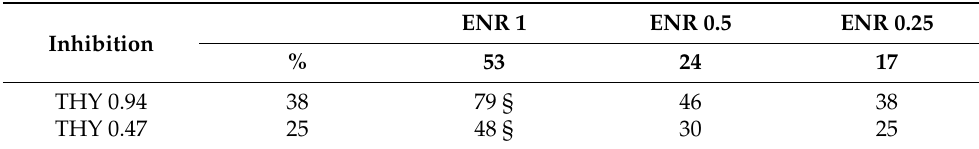
Table 6. Percentage inhibition of the five ETEC strains resistant to amoxicillin in the presence of combinations of amoxicillin (AMO, mg/L) and thymol (THY, mM). AMO 64 AMO 32 AMO 16 Inhibition % 9 14 16 THY 0.94 25 15 26 27 THY 0.47 21 15 24 25 Table 7. Percentage inhibition of the three ETEC strains resistant to neomycin in the presence of combinations of neomycin (NEO, mg/L) and thymol (THY, mM). NEO 64 NEO 32 NEO 16 Inhibition % 6 8 8 THY 0.94 16 11 10 10 THY 0.47 10 9 13